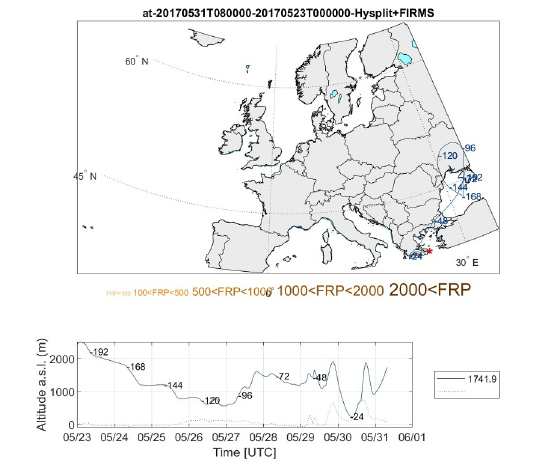
Fig. 4. Hysplit backtrajectory and fires’ location